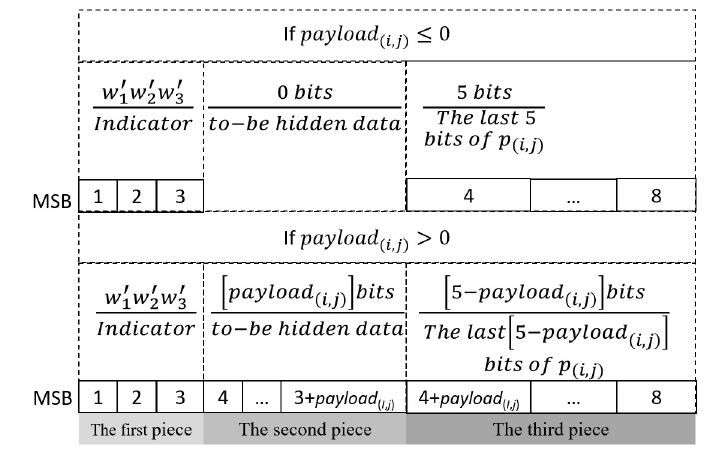
Figure 2. Three pieces of the embedded pixel. Table 1. The pure payloads of the smooth image and complex